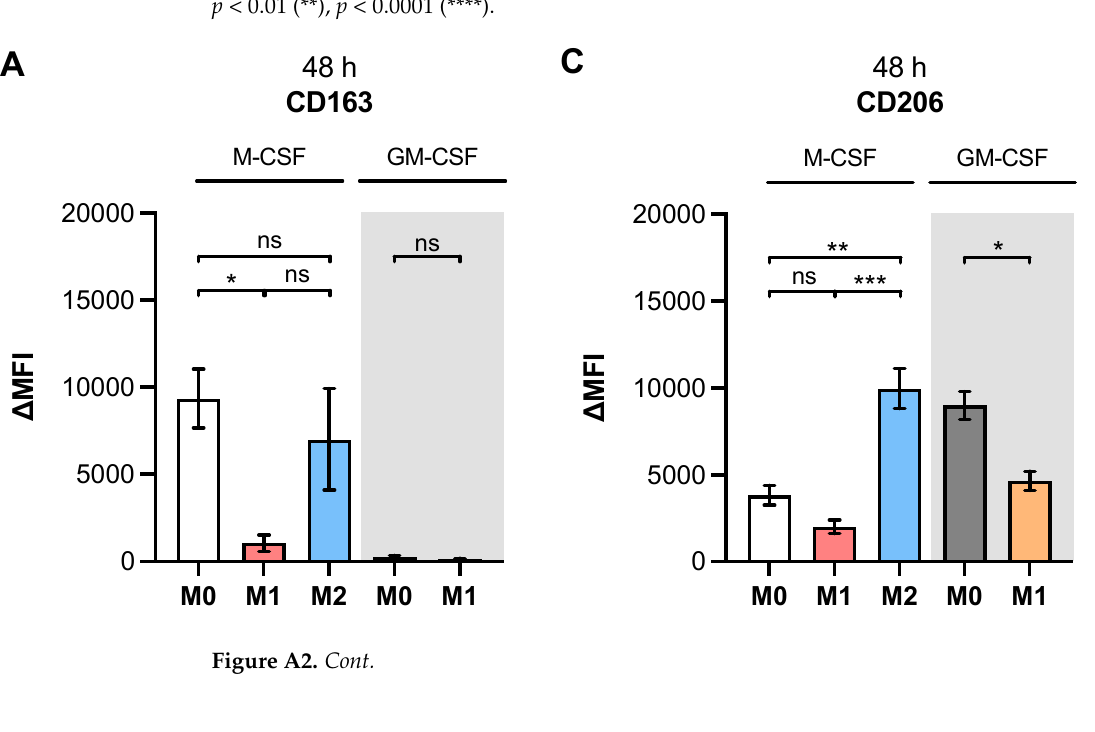
Tukey’s multiple comparison tests, and expressed as mean ± SEM. ns (not significant), p < 0.05 (*), significant), p < 0.05 (*), p < 0.01 (**), p < 0.0001 (****).